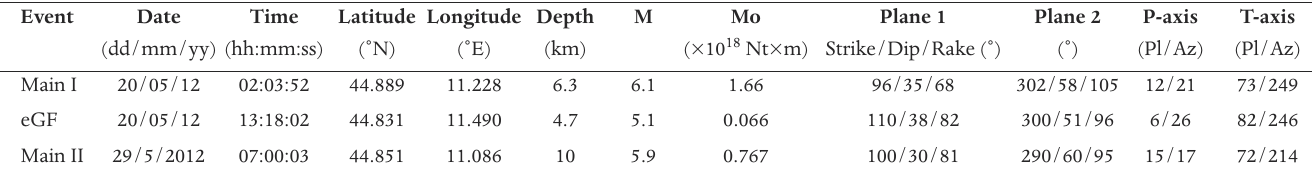
Table 1. Source parameters for the two strongest events of the May 2012 Emilia-Romagna sequence and the strong aftershock, which was used as em- pirical Green's function. Locations are from http://iside.rm.ingv.it and moment tensor related parameters are from the global Centroid Moment